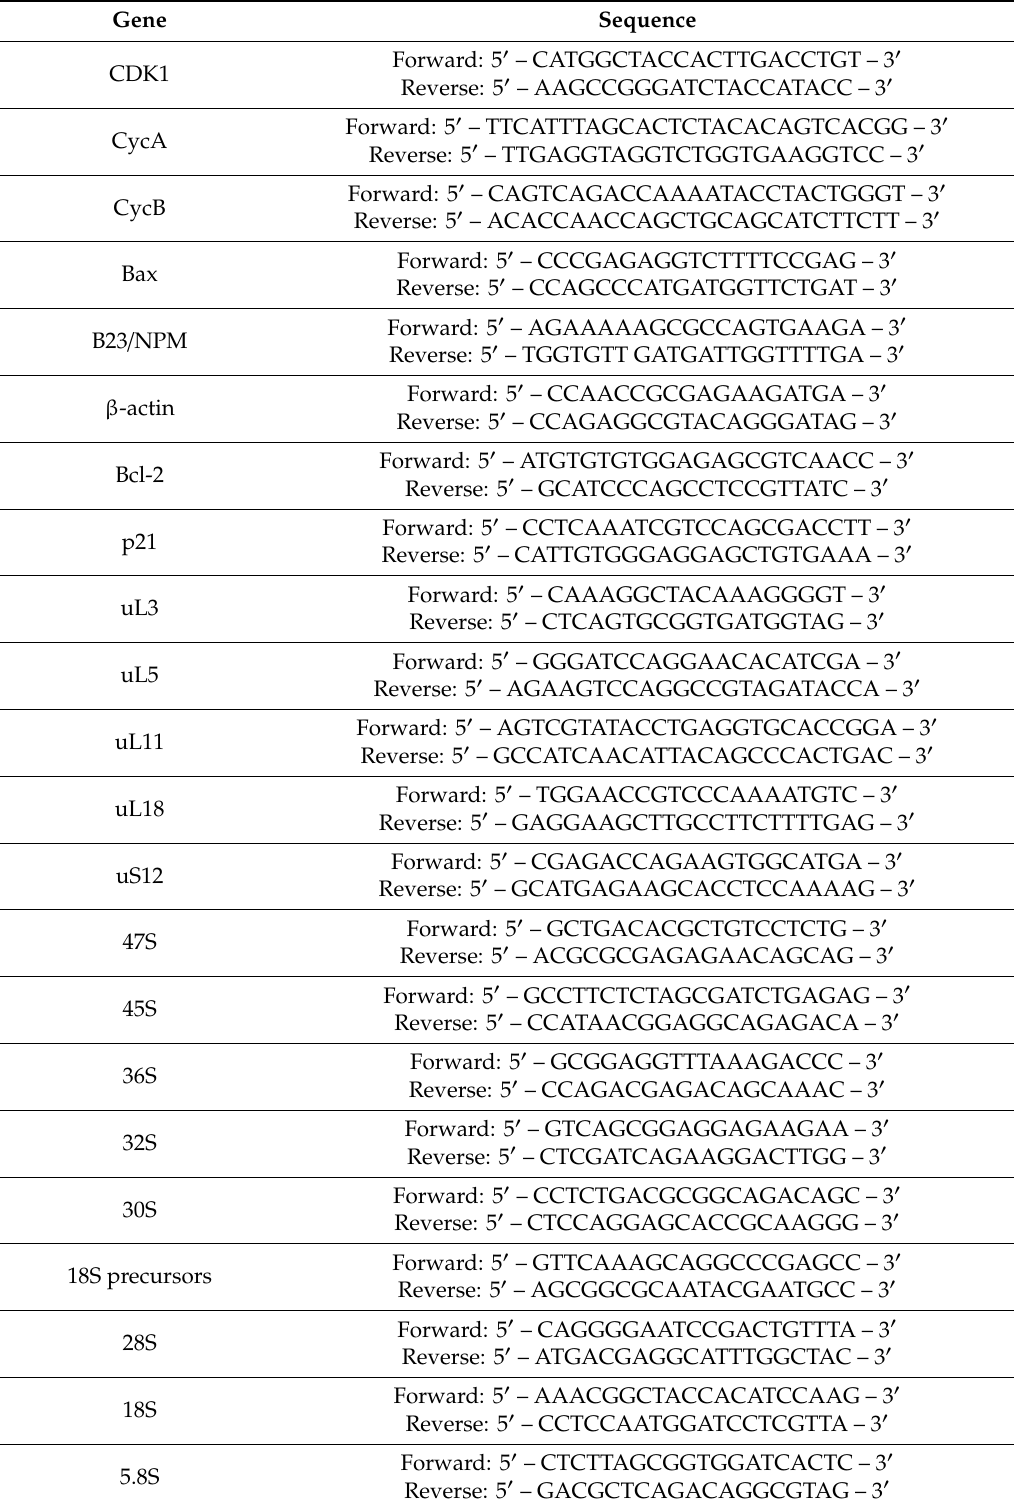
Table 2. Sequence of oligonucleotides used in RT–qPCR